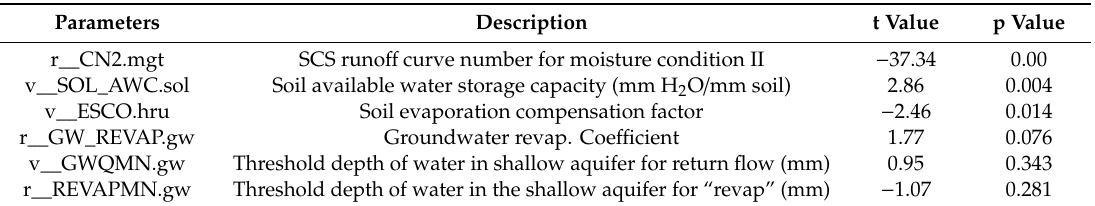
Table 3. Model parameters, their description, and sensitivity analysis results (see SWAT-CUP manual [45] for more details on